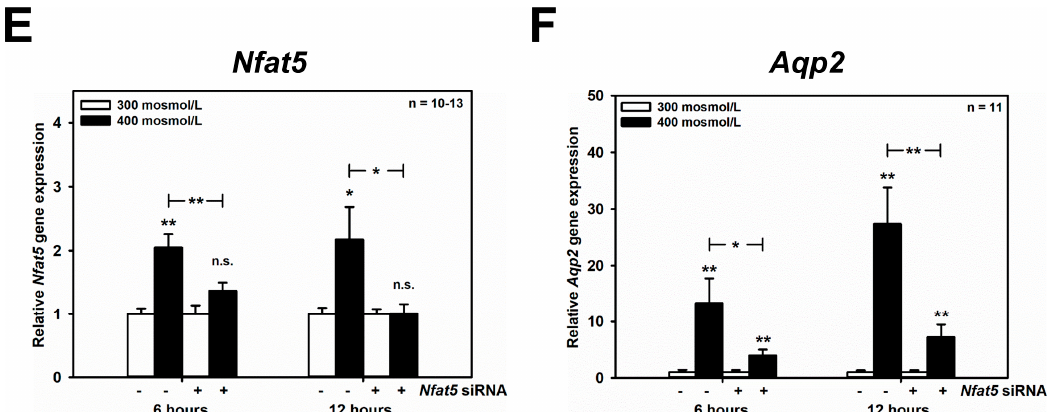
Figure 2. Aqp2 upregulation induced by hyperosmolarity is mediated by NFAT5 in mCCD(cl.1) cells. ( A ) Expression levels of Aqp2 mRNA by RT-PCR in mCCD(cl.1) cells exposed to 300–400 mosmol / L for 12 h. Aqp2 mRNA expression was normalized to Gapdh , and expression levels at 300 mosmol / L are set to 1.0. Data show means ± SEM of four experiments. Statistical analysis compares hyper- to normosmolarity by unpaired t -test. ( B ) Expression levels of Aqp2 mRNA by qPCR in mCCD(cl.1) cells exposed to 300–400 mosmol / L. Means ± SEM of 10 experiments are shown. Data normalized to the expression of Gapdh and Actb show relative expression levels of Aqp2 under hyperosmotic conditions, where expression at 300 mosmol / L is set to 1.0. Statistics compare hyper- to normosmolarity by unpaired t -test. ( C ) mCCD(cl.1) cells were transfected with control or Nfat5 siRNA by electroporation and cultured, as described above, prior to a medium change to 300 and 400 mosmol / L for an additional 24 h, and immunoblotting. β -actin serves as a loading control. The blot is typical of three similar ones. MM = molecular mass. ( D ) Distribution of NFAT5 in homogenate, nuclei and postnuclear supernatant of mCCD(cl.1) cells exposed to 300–500 mosmol / L for 24 h prior to homogenization, subcellular fractionation and immunoblotting of NFAT5. Lamin A / C and GAPDH are markers of nuclei and cytosol, respectively. The immunoblot is typical of three di ff erent blots. MM = molecular mass. ( E , F ) mCCD(cl.1) cells are transfected with siRNA against Nfat5 or control siRNA by electroporation. Then cells are seeded in 25 cm 2 flasks and grown for 24 h, prior to a medium change to 300 or 400 mosmol / L and incubation for an additional 6–12 h. Expression levels of Nfat5 ( E ) and Aqp2 mRNA ( F ) are determined by qPCR, as described above. Statistical analysis shows means ± SEM of 10–13 experiments and compares experimental conditions by one-way ANOVA. n.s. = not significant. For a definition of asterisks, see “statistics” in the Methods.